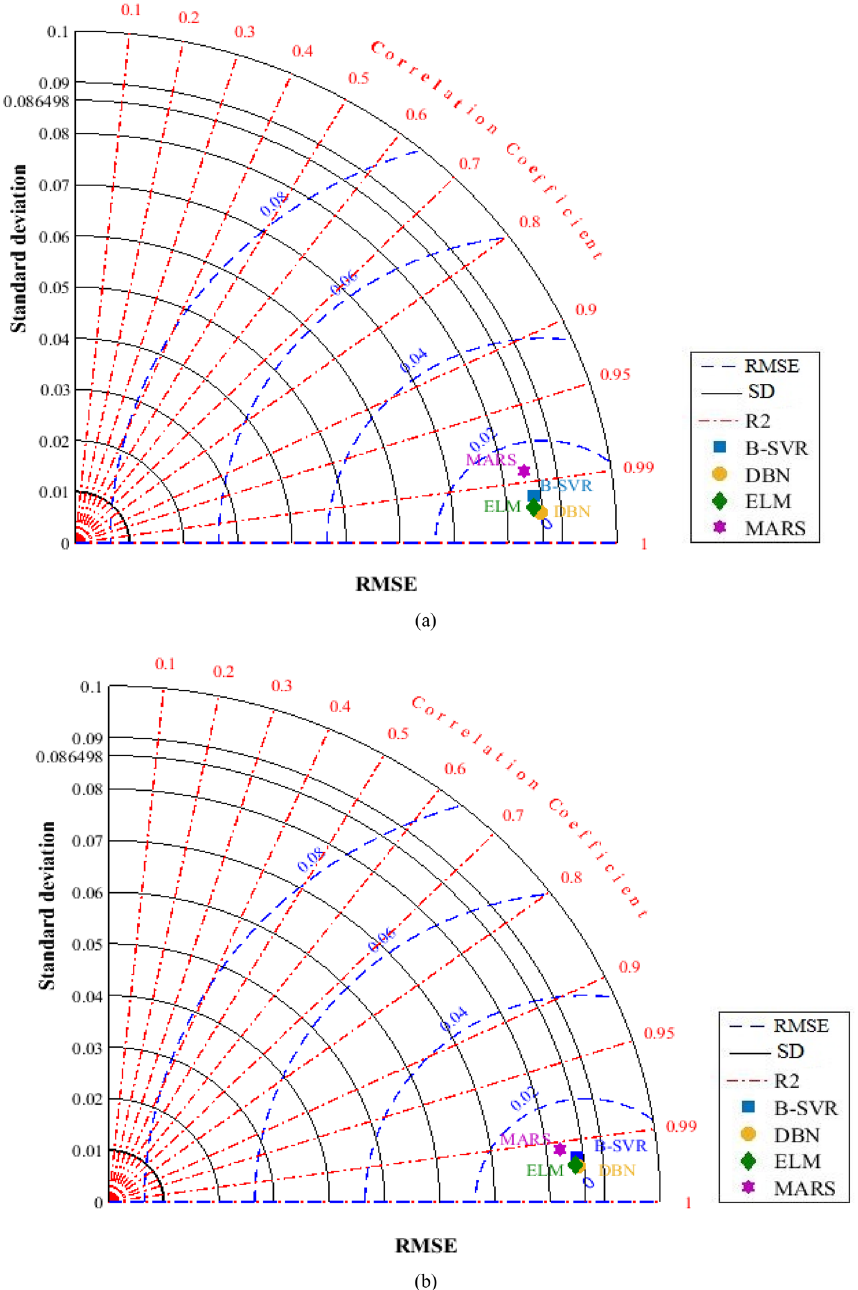
Figure 12. Taylor diagram of developed models: ( a ) Model (I), ( b ) Model